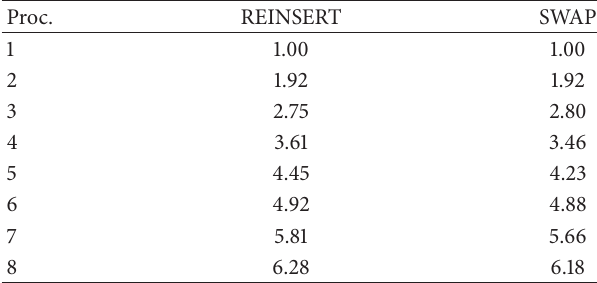
Table 6: Speed-up: 𝑁 (𝐼) with balanced start. Proc.